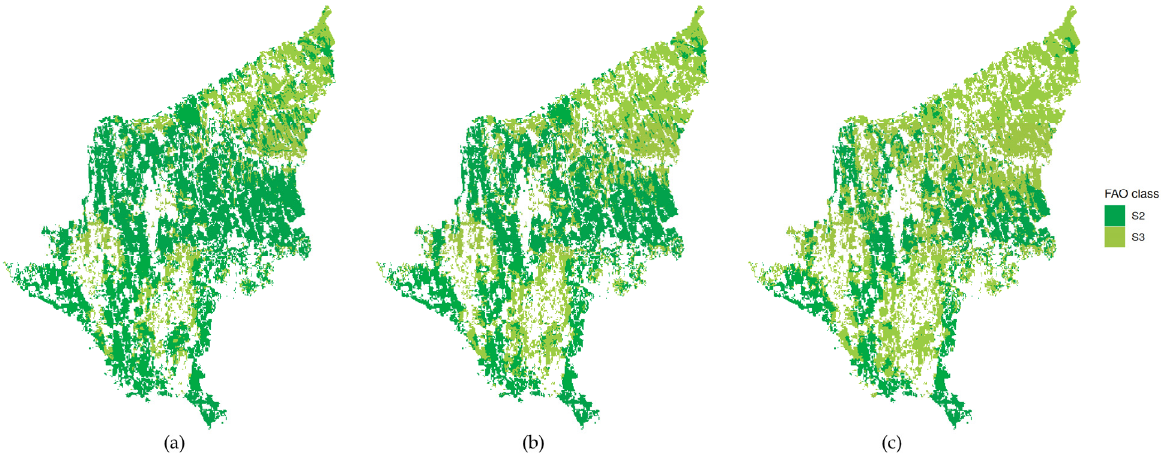
Figure 10. LS classes and validation after implementing SICS for 100 years (maize) in Somogy: ( a ) Cover Crop (CC) and Conservation Tillage (CT); ( b ) Crop Residue Management (CRM); ( c ) Manure Application